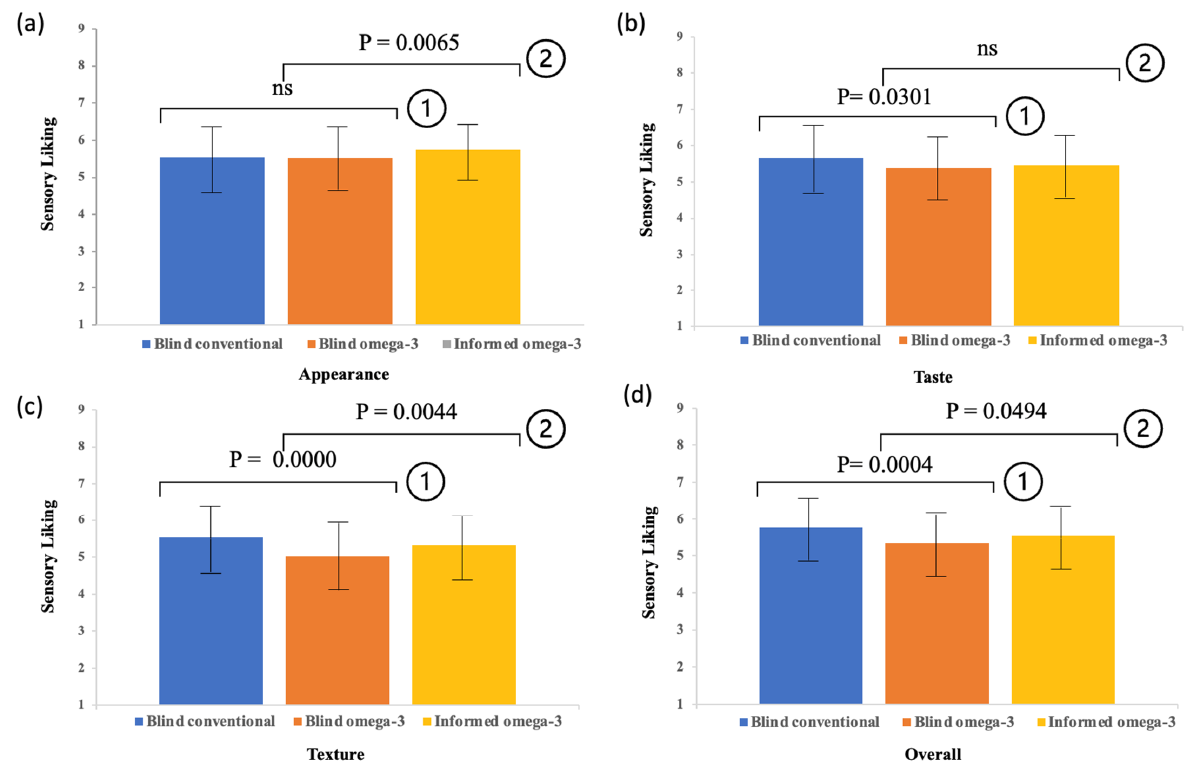
Figure 1. Mean ratings of ( a ) appearance, ( b ) taste, ( c ) texture and ( d ) overall liking are shown. Error bars represent standard deviation of the mean. ① = liking of conventional vs. omega-3 samples in the blind condition (paired Student’s t -test); ② = liking before vs. after the information disclosure of omega-3 samples (paired Student’s t -test).